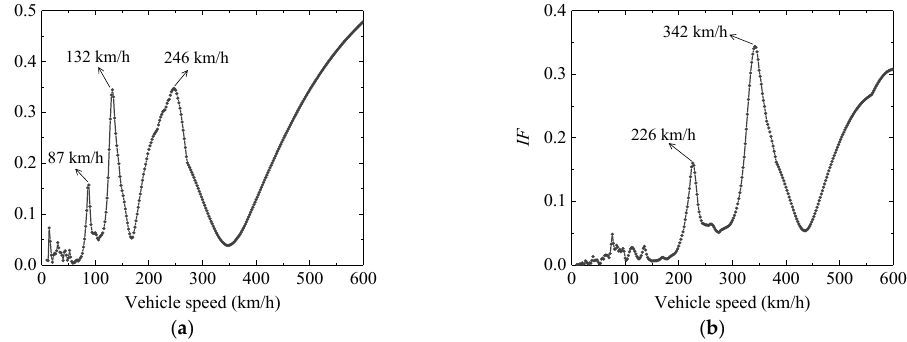
Figure 6. Dynamic impact factor (IF) of bridge spanning 30 m: ( a ) IF of vertical displacement; ( b ) IF of radial displacement.